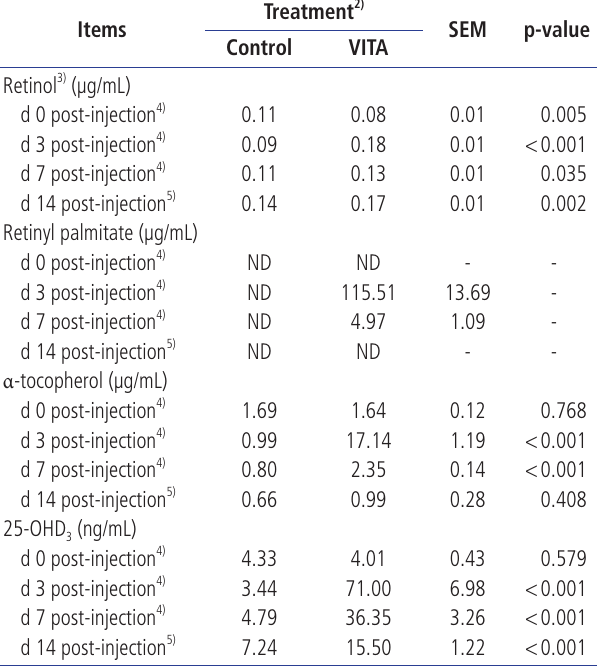
Table 3. Retinol, retinyl palmitate, α -tocopherol, and 25OHD plasma of pigs administered with fat-soluble vitamins 1) Items